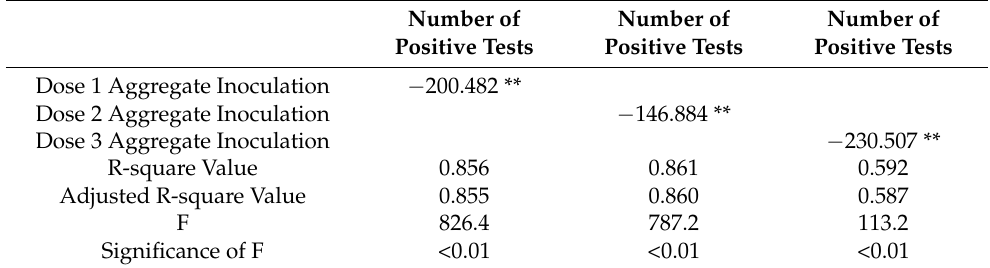
Table 14 indicates that the aggregate number of people who were inoculated by dose 1 explains 85.6% of the variance in the daily number of people who tested positive. Dose 2 accounts for 86.1% of the variance in the daily number of people who tested positive. Dose 3 accounts for 59.2% of the variance in the daily number of people who tested positive. Table 14. Regression between the daily number of people who tested positive and doses 1, 2, and